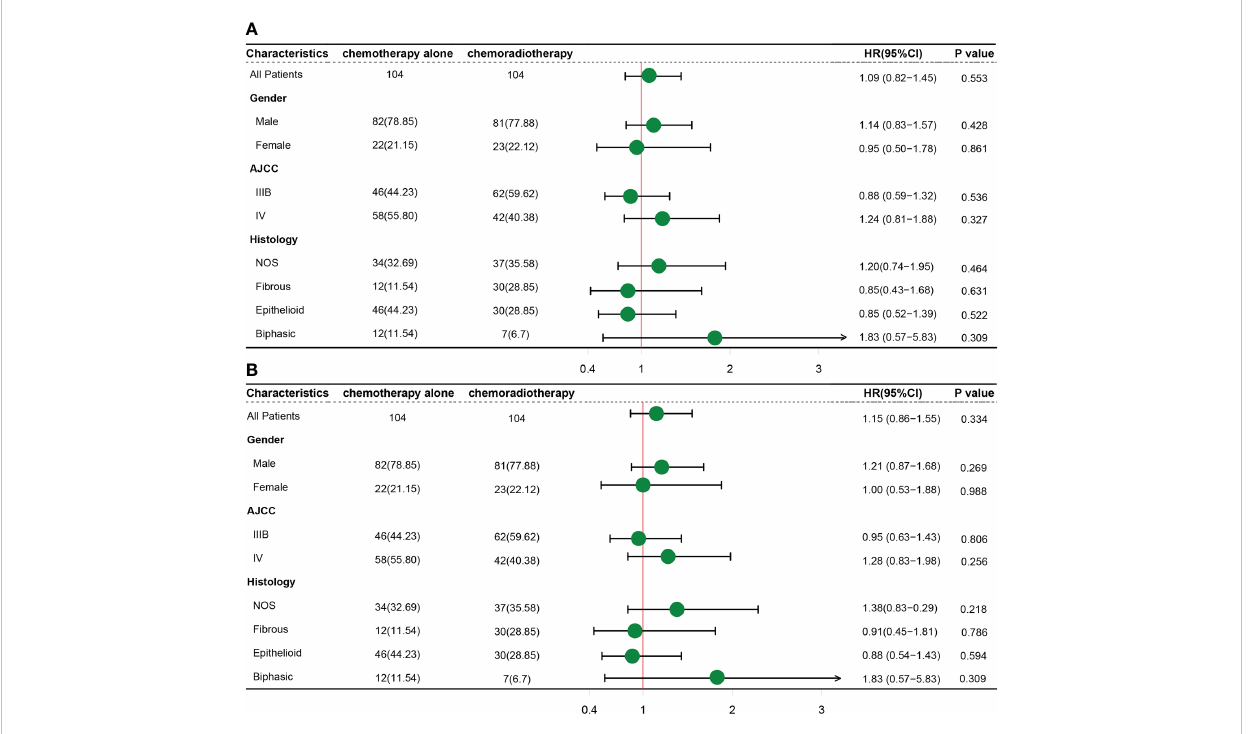
FIGURE 7 Subgroup analysis of differences in OS (A) and CSS (B) in the two treatment